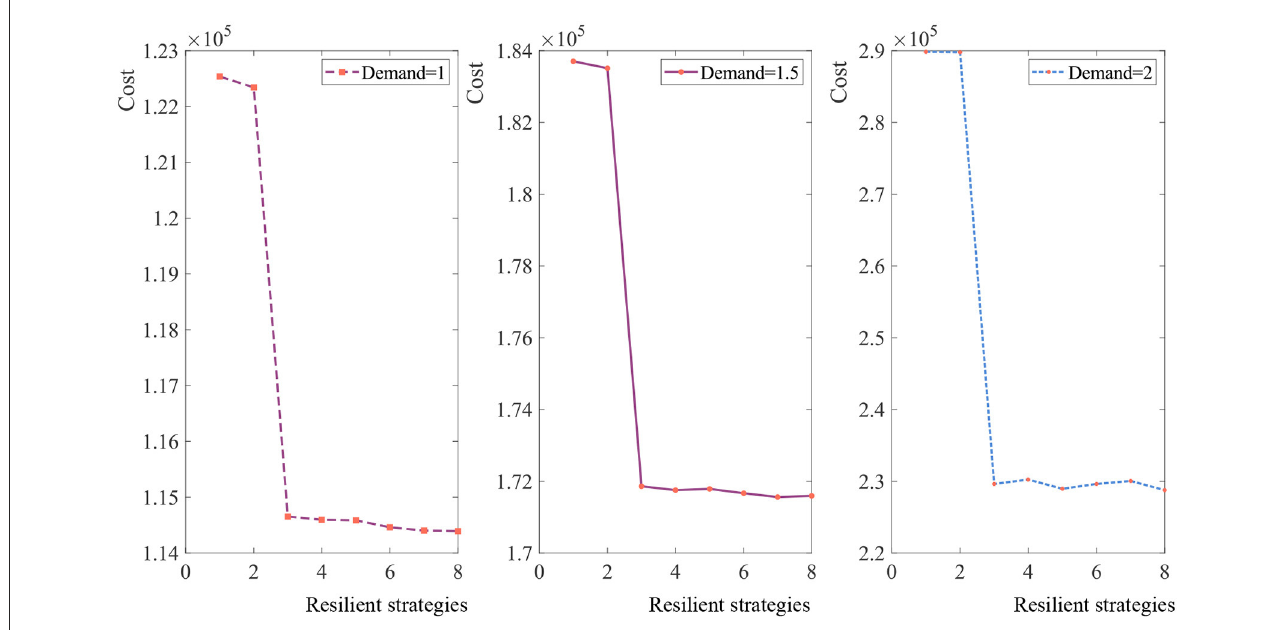
FIGURE6 The expected total cost under different resilient strategies.